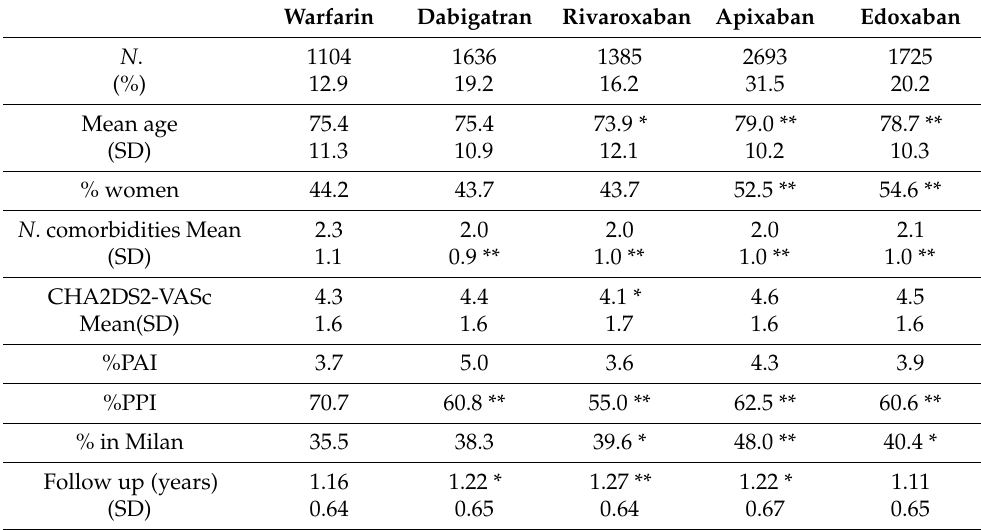
Table 2. Characteristics of the atrial fibrillation patients for each analyzed anticoagulant agent. Warfarin Dabigatran Rivaroxaban Apixaban